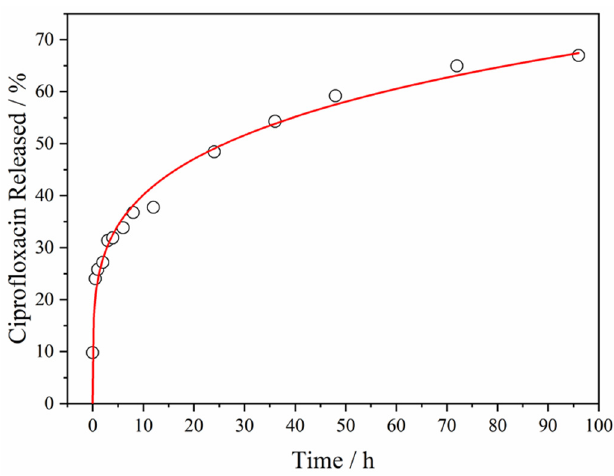
Figure 6. Profile of CIP release from ZnO@ZIF-8 into PBS solution at pH 7.4, at 37 °C. The data were fit to the Korsmeyer–Peppas equation, as indicated by the red line.